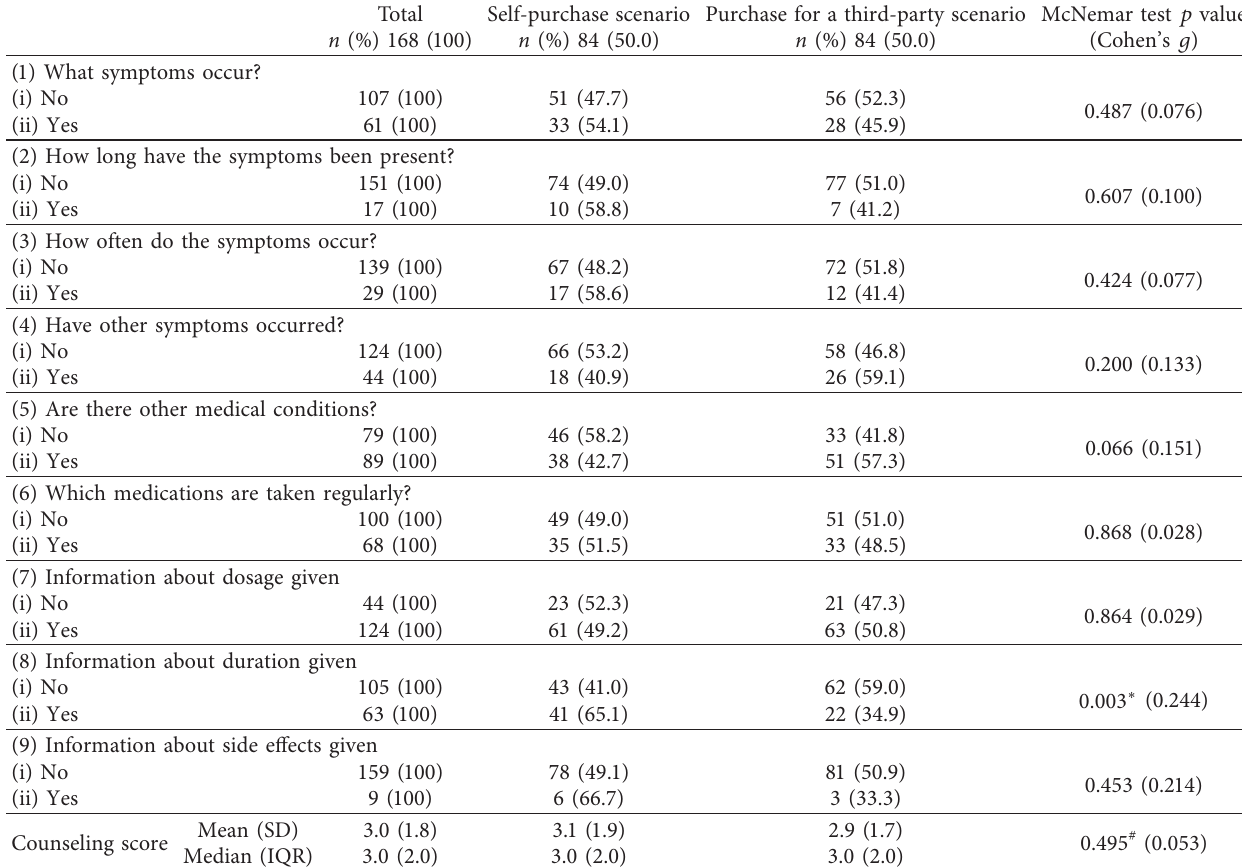
Table 6: Assessment items and counseling score by scenario